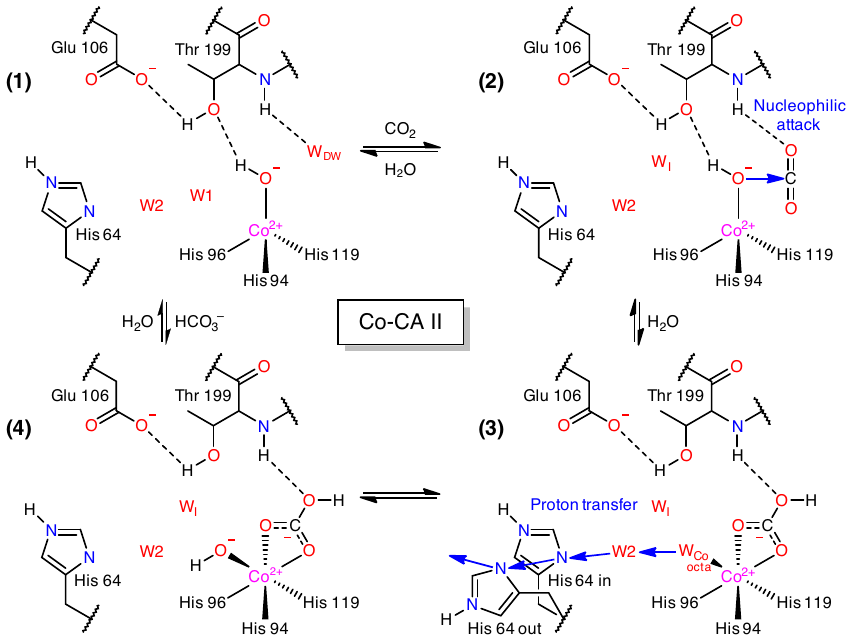
Fig. 7 Proposed catalytic mechanism of Co-CA II. In Co-CA II, CO 2 binding and the catalytic conversion of CO 2 to HCO 3 − occur in the same way as in the Zn-CA II with tetrahedral geometry. However, the HCO 3 − displacement and proton transfer process are signi fi cantly altered due to the coordination expansion to octahedral geometry during catalysis. This octahedral coordination allows bidentate binding mode of HCO 3 − and reorganization of negative charge of HCO 3 − toward Co 2 + ion, allowing stronger HCO 3 − binding to metal ion. To dissociate the product, proton transfer fi rst occurs via an altered pathway (possibly, W Co,octa → W2 → His64) and W Co,octa is converted into the hydroxyl ion. This negatively charged hydroxyl ion then pushes away the bound product, and the tetrahedral coordination is restored for the next catalytic